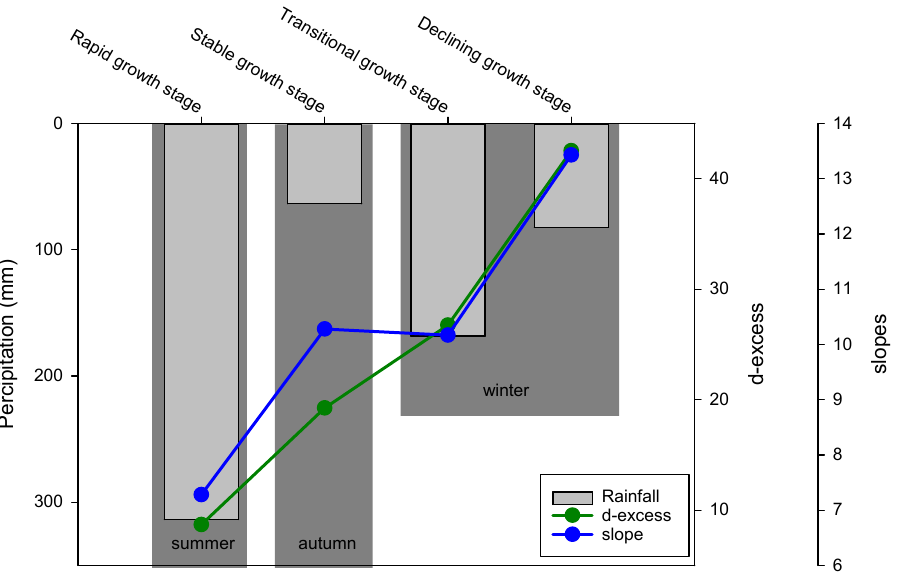
Figure 6. Rainfall vs d-excess and slopes from the Figure